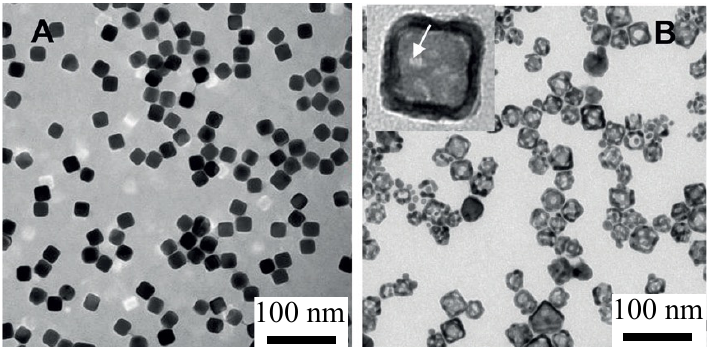
Figure 5. ( A ) Transmission electron micrograph of silver nanocubes formed by the polyol reaction following 30 min of growth. The cubes are monodisperse with well-defined sharp edges. The mean size of the silver nanocubes is 18 nm. ( B ) TEM image of hollow gold nanoshells (HGN) made from the silver templates in ( A ) by the galvanic replacement according to the reaction in Equation (3). The inset shows a high magnification image illustrating the hollow shape with pores in the walls (arrow). The mean size of the hollow gold nanocubes in ( B ) increased to 23 nm, and the size distribution broadens. Adapted from [45], published by Wiley,